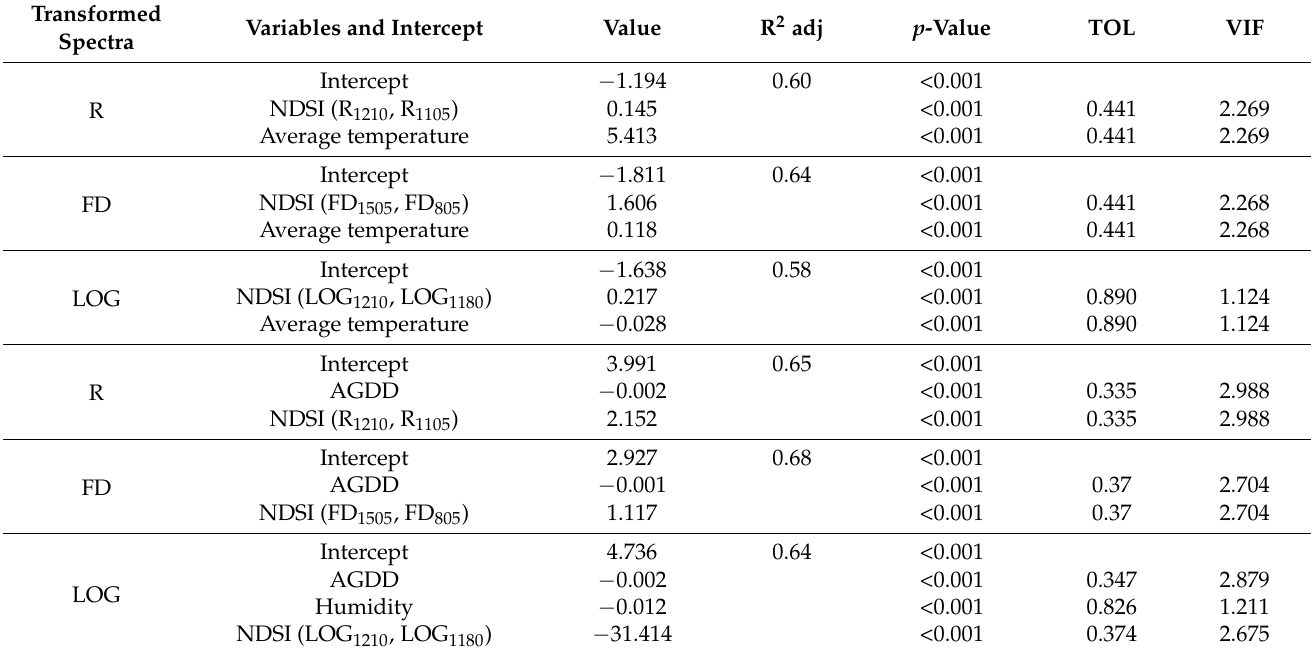
Table 6. Results of stepwise multiple linear regression with spectral indices and meteorological data using the calibra- tion